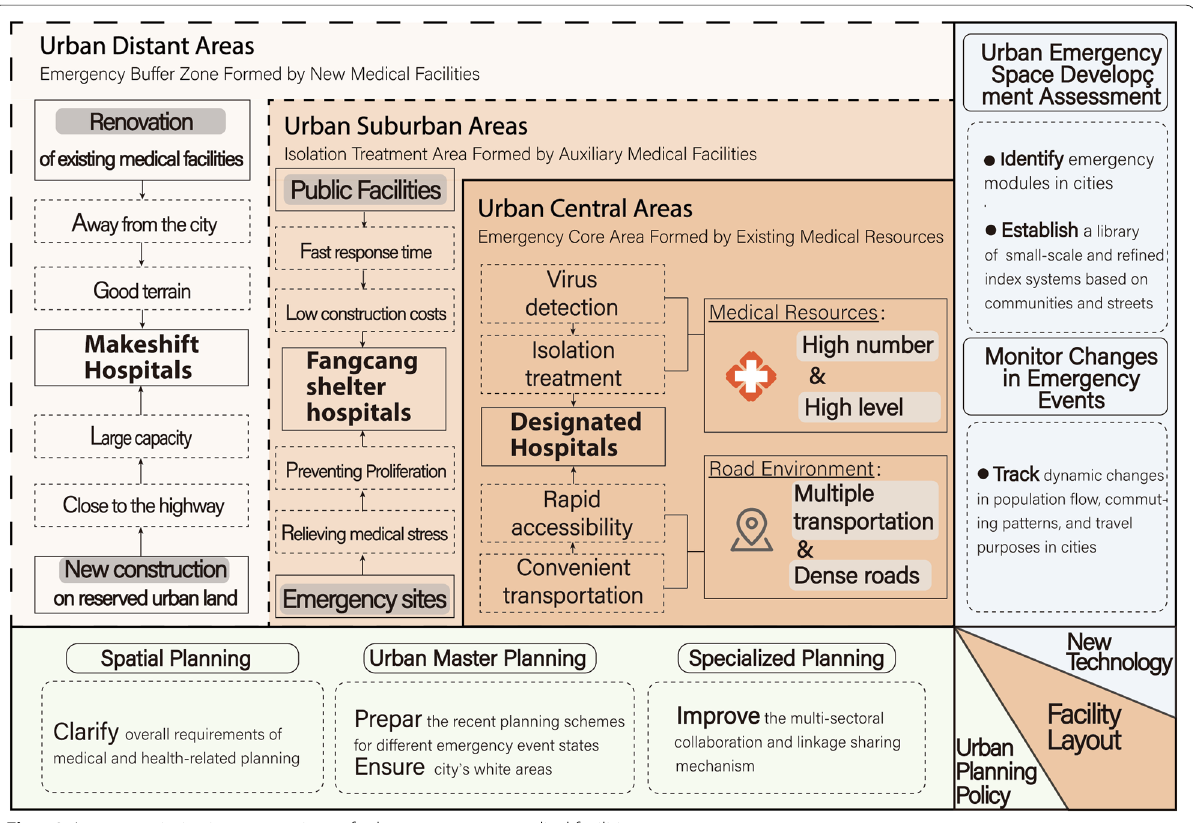
Fig. 10 Layout optimization suggestions of urban emergency medical